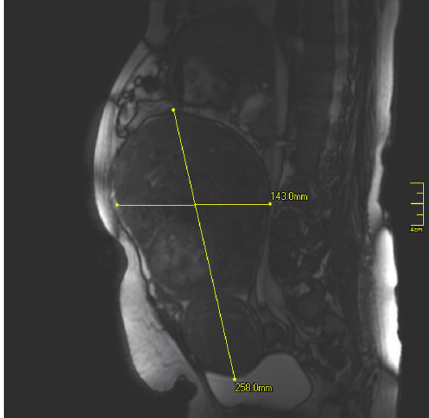
Figure 2: The figure shows the sagittal view of mass that is filling abdominopelvic cavity.